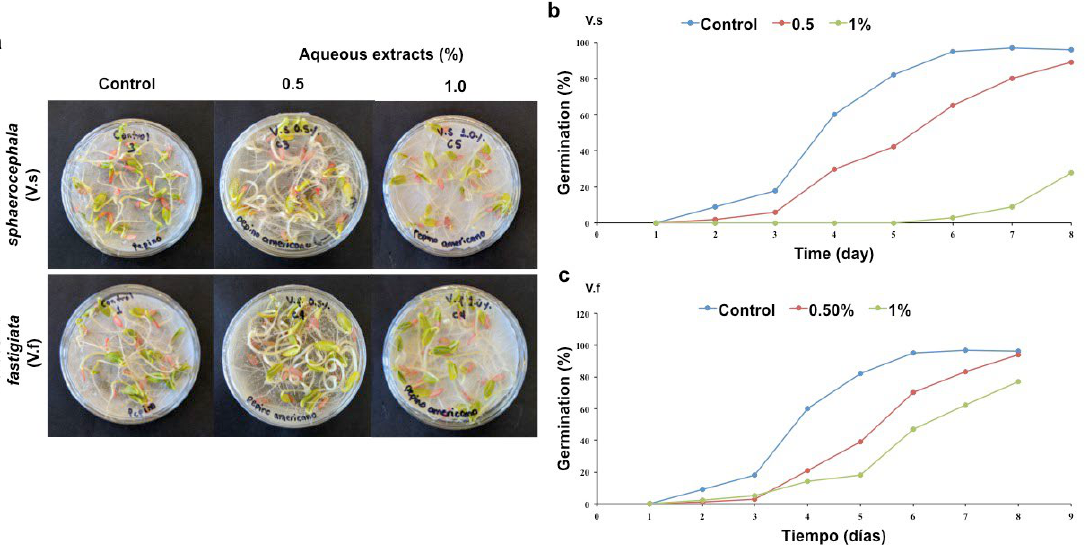
Figure 2. Germination of cucumber ( Cucumis sativus ) seeds. ( a ) Application of the aqueous extracts of Verbesina sphaerocephala and Verbesina fastigiata at concentrations of 0.5 and 1.0%. ( b ) Germination percentages (GP) obtained with the aqueous extracts of V. sphaerocephala ( n = 100, p = 0.05) and (c) V. fastigiata ( n = 100, p = 0.05).